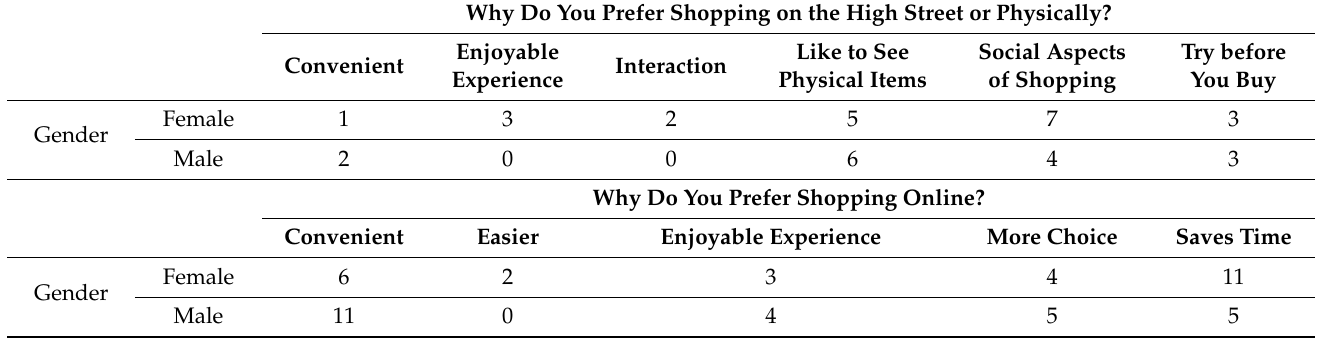
Table 3. Why do respondents prefer shopping on the highstreet or online?